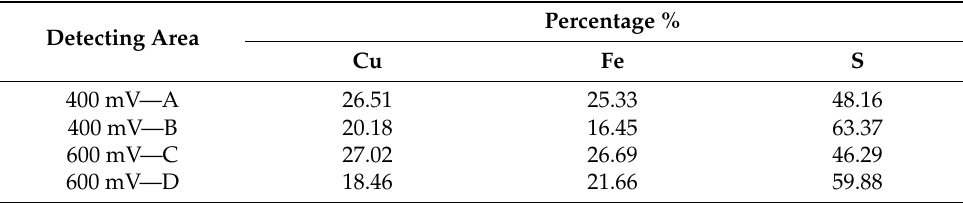
Table 3. EDS results of the leaching